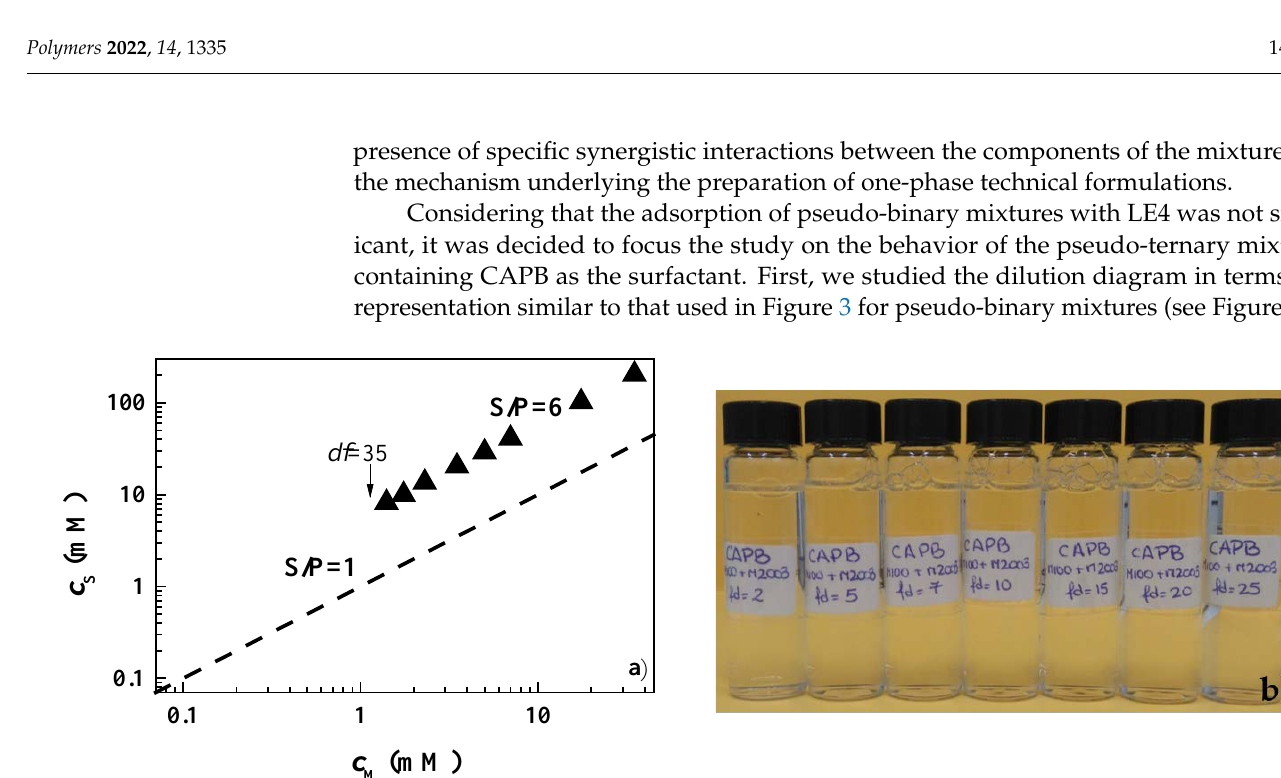
Figure 12. ( a ) Acoustic thickness before (□) and after ( ■) rinsing/ dilution for the adsorption of pseudo-ternary polymer–CAPB mixtures obtained upon dilution at different values of df of a pseudo-ternary polymer–surfactant mixtures with the same concentrations of the individual components as those that are presented in the formulation of Table 2 ( b ) Comparison of the acoustic ( ■ ) and optical ( ■ ) thicknesses for the deposition of layers of the polymer–CAPB pseudo-ternary mixtures, and water content of the deposited layers (bar charts), for samples at different values of the dilution factor. Notice that the solid lines represent the acoustic (―) and optical (― ) thicknesses for the adsorption of a solution containing a mixture of the two polymers in the same concentration as in Table 2, i.e., a concentration of polymer equivalent to df = 1.